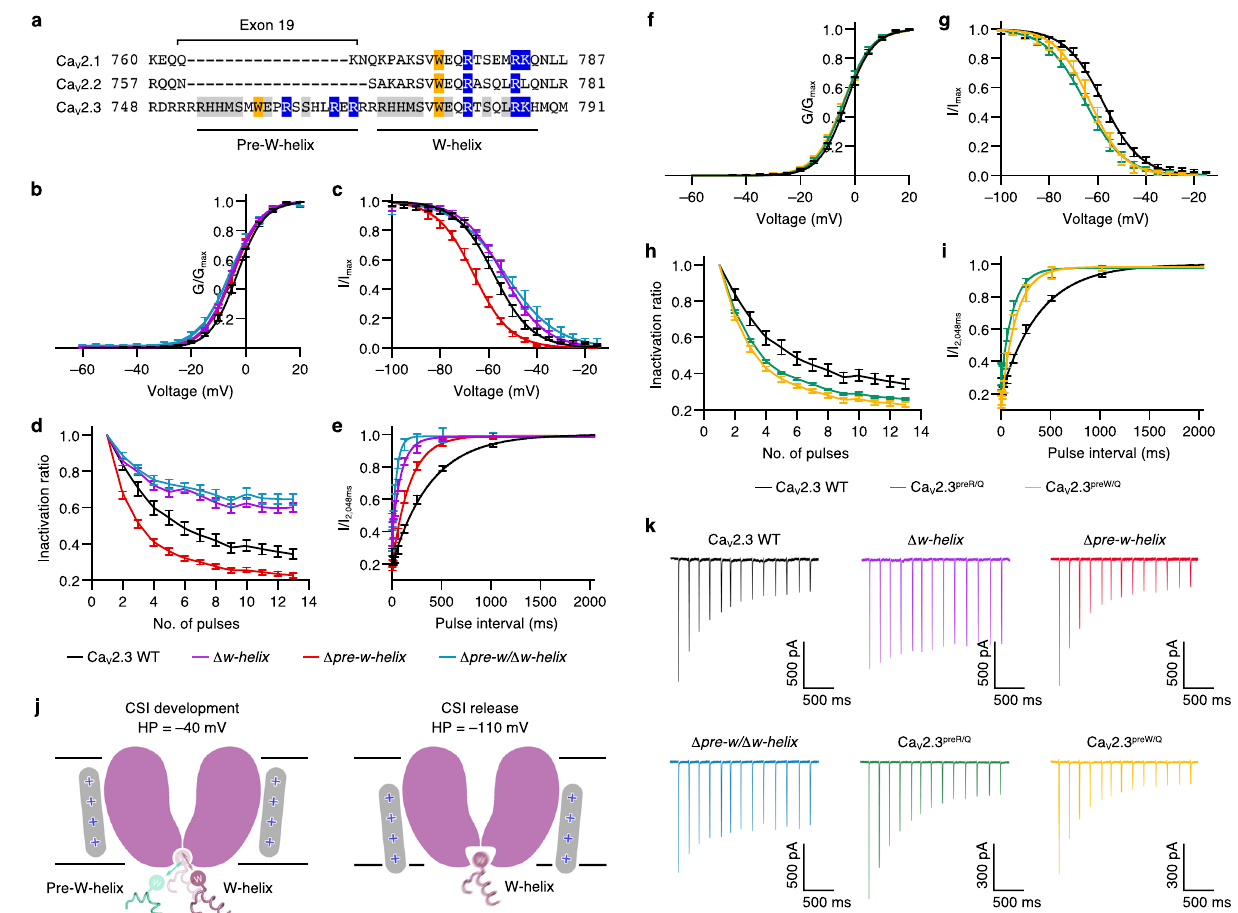
Fig. 4 | CSI regulation by pre-W-helix. a Sequence alignment of the DII-III linker amongtheCa V 2members.Residuesonthepre-W-helixandW-helixareunderlined andlabeled,respectively.Exon19onthegenomicDNAofCa V 2.3encodingthepre- W-helix is also labeled. b , g Activation curves of the wild-type Ca V 2.3 and the mutants. Ca V 2.3 WT, n =14; Δ w-helix , n =7; Δ pre-w-helix , n =7; Δ pre-w/ Δ w-helix , n =7; Ca V 2.3 preR/Q , n =7; Ca V 2.3 preW/Q , n =8. c , h Steady-state inactivation curves of wild-type Ca V 2.3 and the mutants. Ca V 2.3 WT, n =9; Δ w-helix , n =8; Δ pre-w-helix , n =7; Δ pre-w/ Δ w-helix , n =7; Ca V 2.3 preR/Q , n =8; Ca V 2.3 preW/Q , n =6. d , i Inactivation ratio quanti fi ed using I/I Peak elicited by the AP trains. Ca V 2.3 WT, n =13; Δ w-helix , n =9; Δ pre-w-helix , n =13; Δ pre-w/ Δ w-helix , n =14; Ca V 2.3 preR/Q , n =9; Ca V 2.3 preW/Q , n =13. e , j Recovery rate from the CSI, quanti fi ed using the previously described two-pulseprotocol.Ca V 2.3WT, n =6; Δ w-helix , n =6; Δ pre-w-helix , n =7; Δ pre-w/ Δ w- helix , n =6; Ca V 2.3 preR/Q , n =8; Ca V 2.3 preW/Q , n =7. f Proposed model of the putative